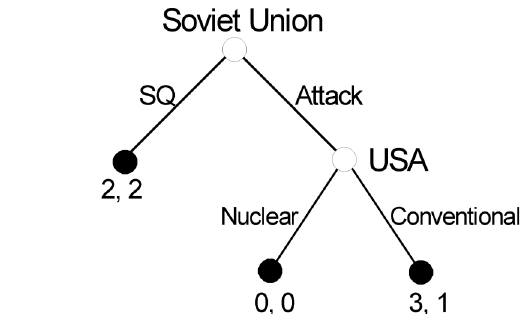
Figure 1. Cold War